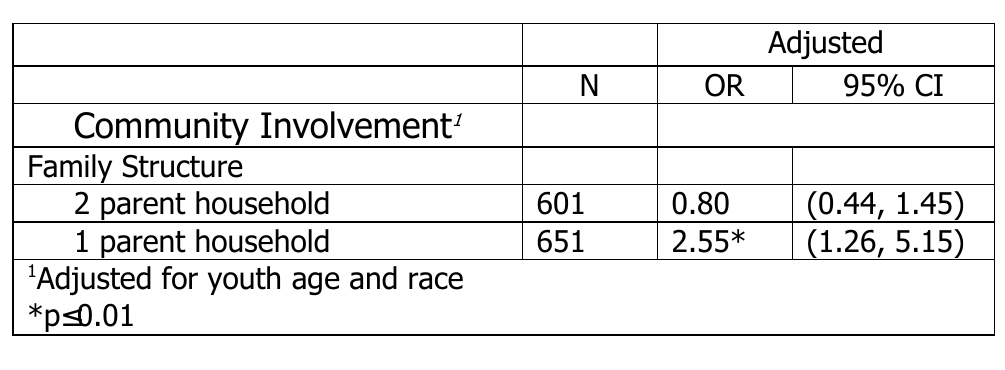
Adjusted Parental Income Specific Odds Ratios (OR) with 95% Confidence Intervals (CI) from Individual Multiple Logistic Regression Models for Non-use of